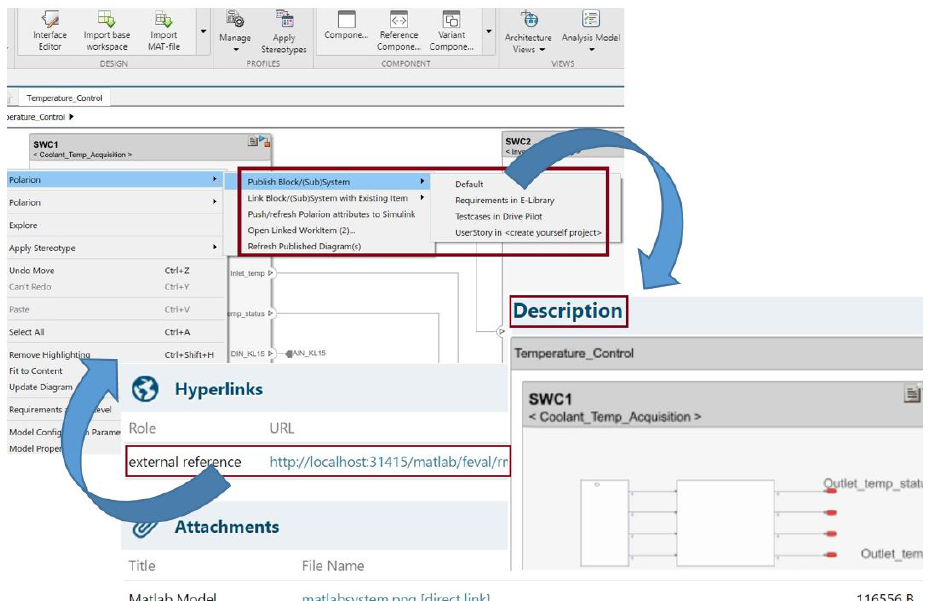
Figure 10. Architectural model authoring and update-practiced in the new approach provides a seamless way to publish the design to requirements database. Additionally, for existing requirements, it provides an option to link them. Whenever the model becomes updated due to maturity of the project, the refresh option could update the same model onto the requirements database. Inversely, any requirement attributes changed on the requirements database can easily be pushed back to the modeling